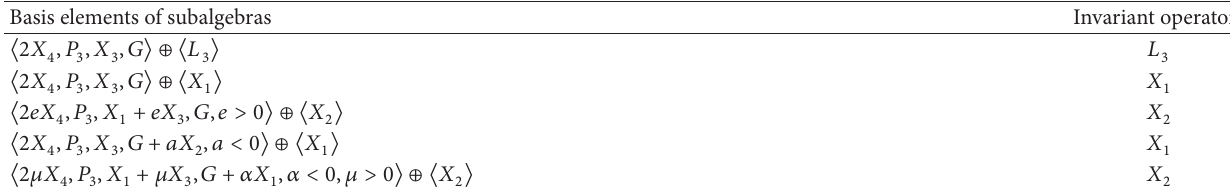
Table 14: Invariant operators of subalgebras of the type 𝐴 𝑏 4,9 ⊕ 𝐴 1 (𝑏 = 0) .